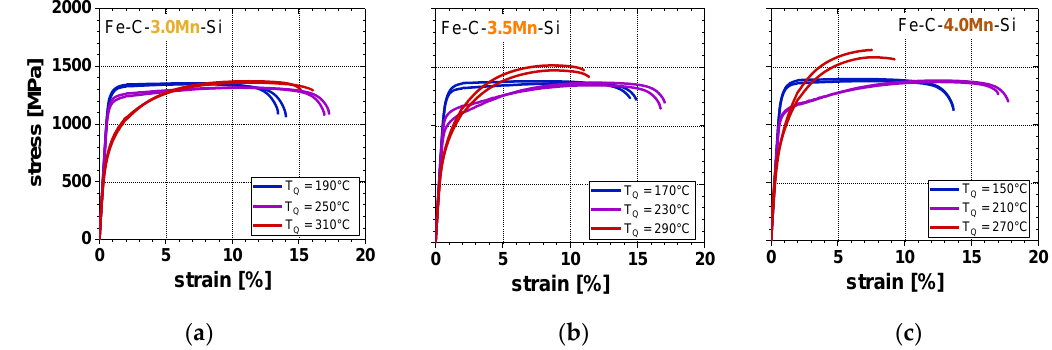
( c ) Figure 5. Phase fraction as a function of T Q for the ( a ) Fe-C-3.0Mn-Si, ( b ) Fe-C-3.5Mn-Si, and ( c ) Fe-C-4.0Mn-Si steels. 3.3. Tensile Testing Representative engineering stress-strain curves for the investigated steels are presented in Figure 6 . For the samples containing approximately 85 vol.% α’